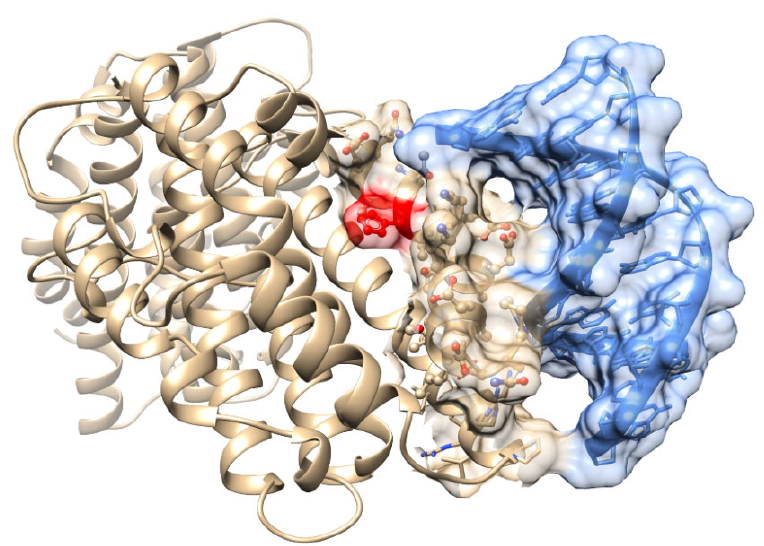
Figure 5. HO-1 DNA binding domain 2 is localized to the heme binding domain of HO-1. We presented that HO-1 DNA binding domain 2 (HO-1 DBD-2) contains peptide residues which surround the heme-binding functional ring of HO-1 on peptide residue His25 (red). The solvent-excluded molecular surfaces of the HO-1 peptide residue molecules within HO-1 DBD-2 were visualized as a semitransparent tan surface. The semitransparent transparent solvent-excluded molecular surfaces were used to show the 10 bp dsDNA molecule (blue) predicted to bind HO-1 DBD-2. dsDNA and HO-1 peptide residue contacts were illustrated where the molecular surface of the dsDNA (blue) merges with the molecular surface of the HO-1 DBD-2 peptide residues (tan). Table 2. Summary of dsDNA-peptide contacts for three HO-1 DNA binding domains. HO-1 DNA Binding Domains